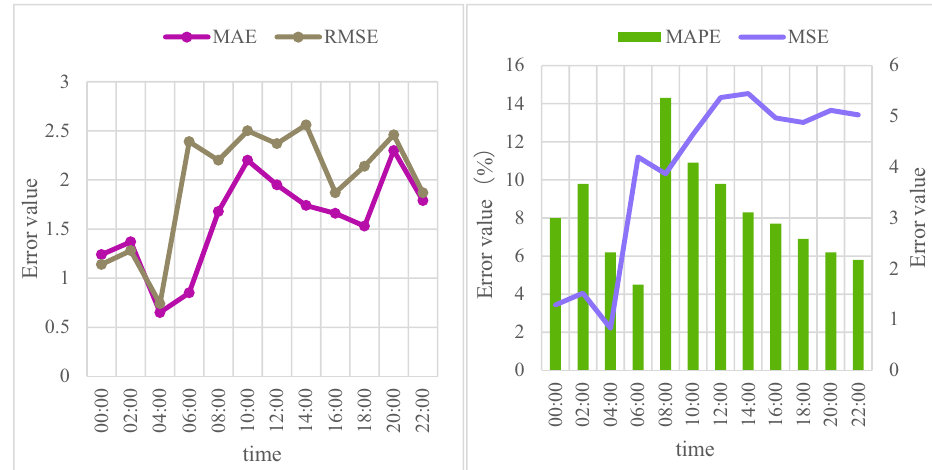
Figure 9: Grid load forecast error value.